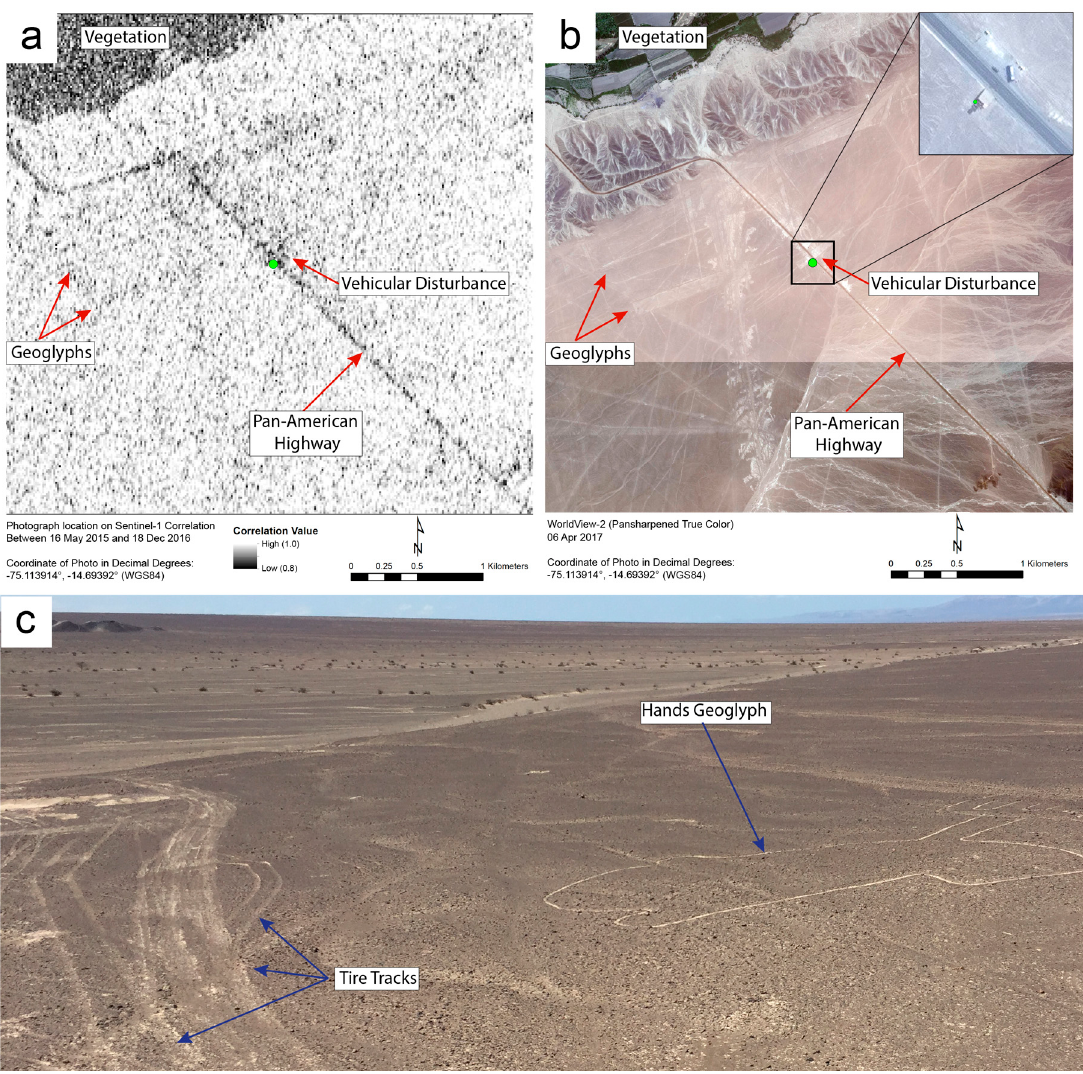
Figure 6. Panel ( a ) reveals slight disturbance to geoglyphs west of the Pan-American Highway and heavier disturbance, caused by vehicles, near the observation tower. These geoglyphs and the tower are visible in ( b ). In both ( a , b ), the tower is marked by the green dot, which is where the photo in ( c ) was taken. This photo shows vehicle tracks off the east side of the highway, running very near the Hands geoglyph. In ( a ), these tracks manifest as a patch of dark pixels near the green dot, and the highway appears as a dark line running southeast-northwest.